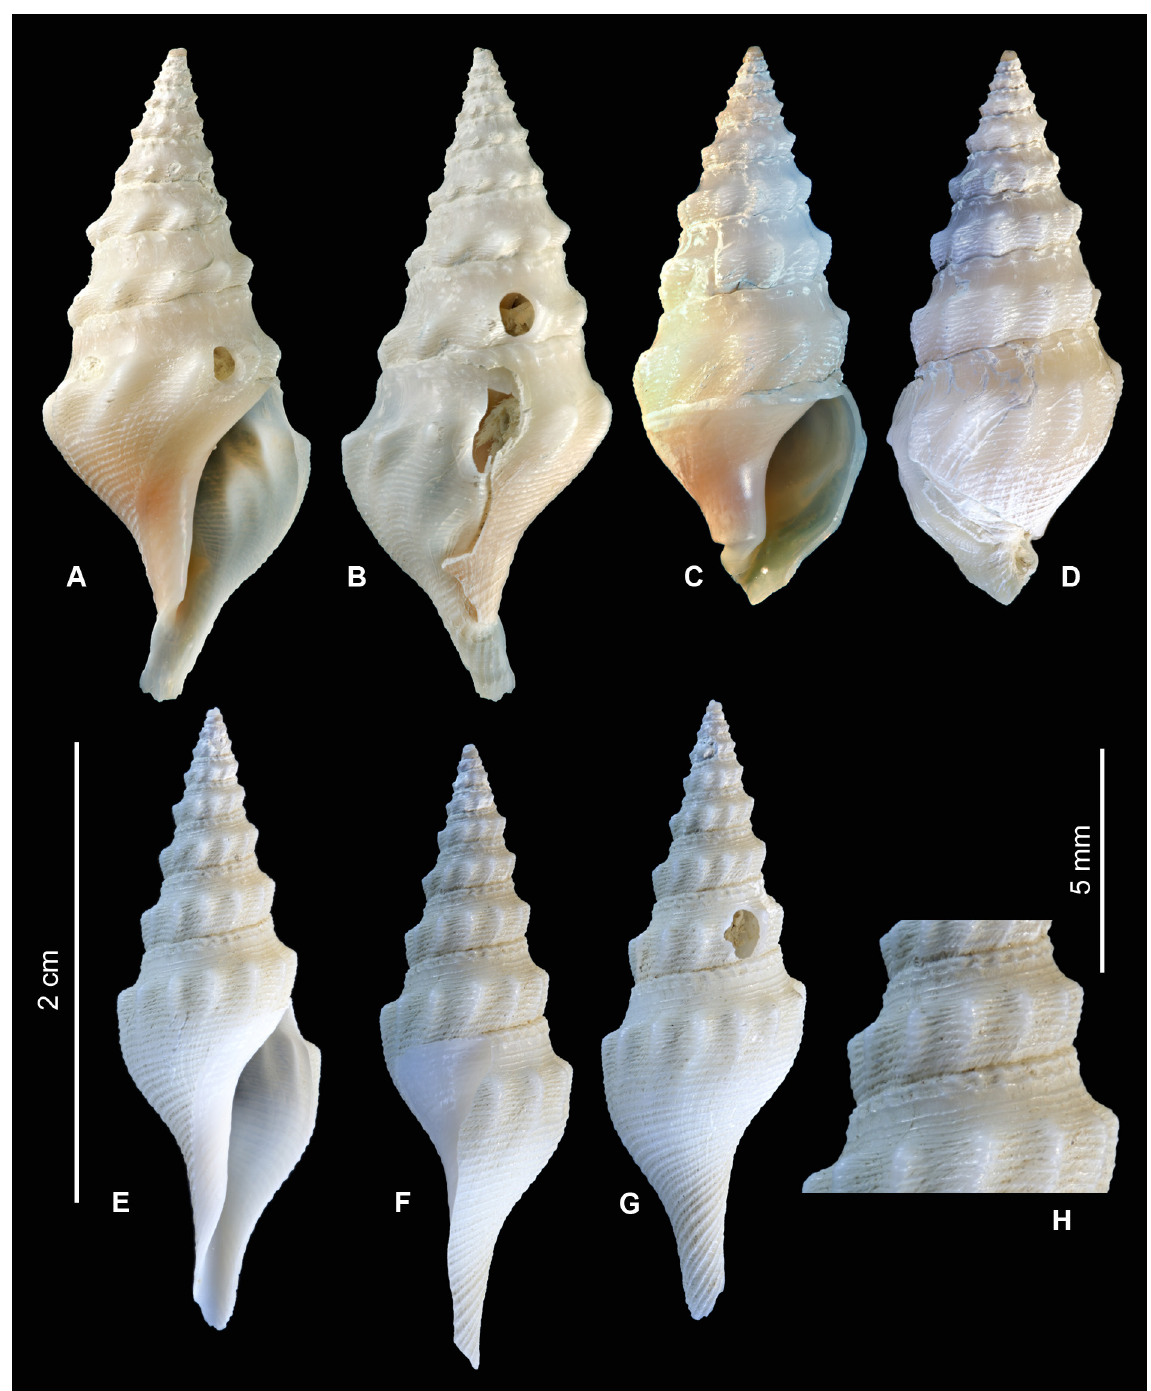
Fig. 12. A–D . Sibogasyrinx pagodiformis sp. nov. A–B . Solomon Islands, holotype, MNHN- IM-2009-16825, SL 28.8 mm. C–D . Vanuatu. MNHN-IM-2009-11327, SL 24.3 mm. E–H .